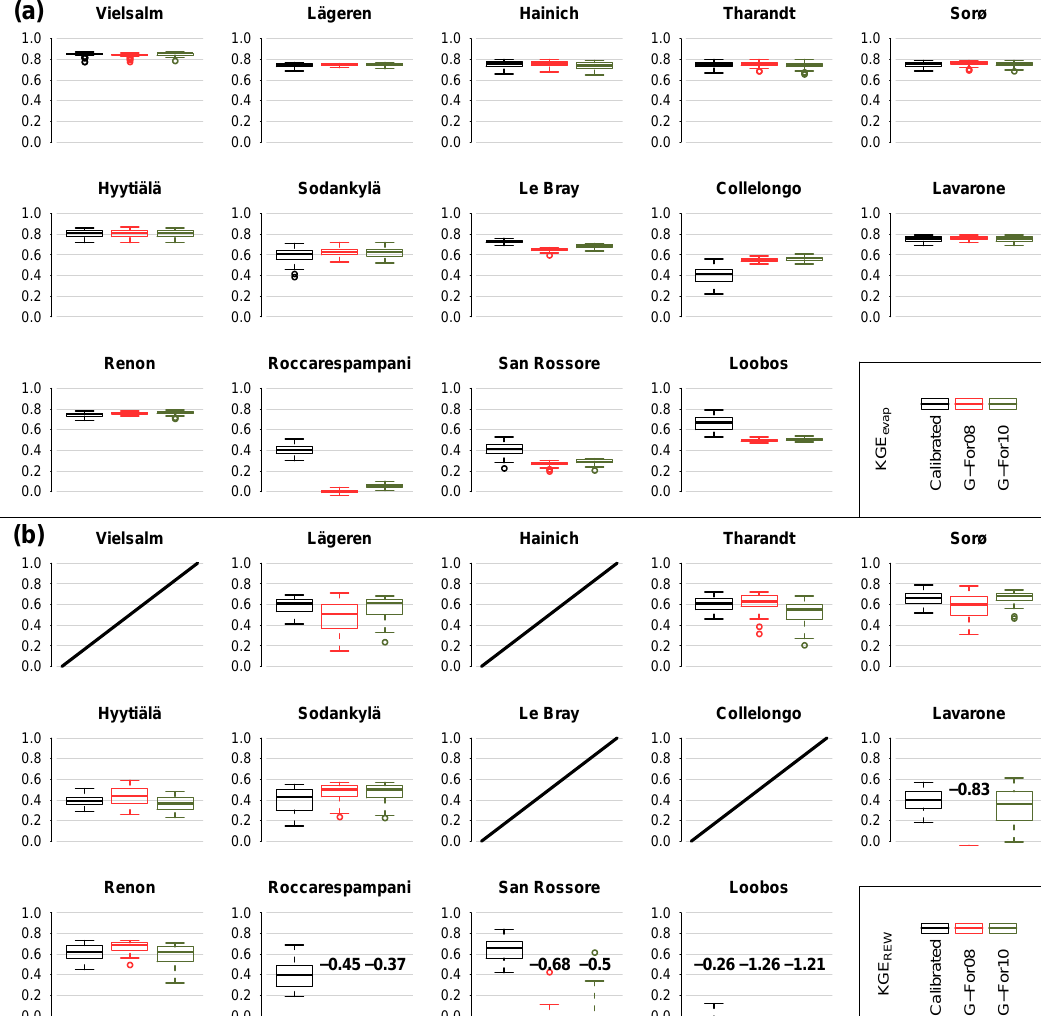
Figure 8. KGE scores obtained during the validation, for total evaporation E tot (a) and relative extractable soil moisture REW (b) . The boxes in each plot correspond to the three sets of validation runs listed in Table 3 (parameter sets derived from calibration, and their two variants with S r replaced with the value from the G-For08 and G-For10 models). The center of the boxes represents the median of KGE scores, and the lower and upper bounds of the boxes show the first and third quartiles, respectively. The whiskers extend to the furthest values within 1.5 times the interquartile range (IQR) from the box bounds. Where the majority of KGE scores are below zero, the median is printed on the plot. No validation runs were done for Wetzstein, due to the short data record. Also, no soil moisture time series were available for validation at the four sites for which the graphs are crossed out on (b)